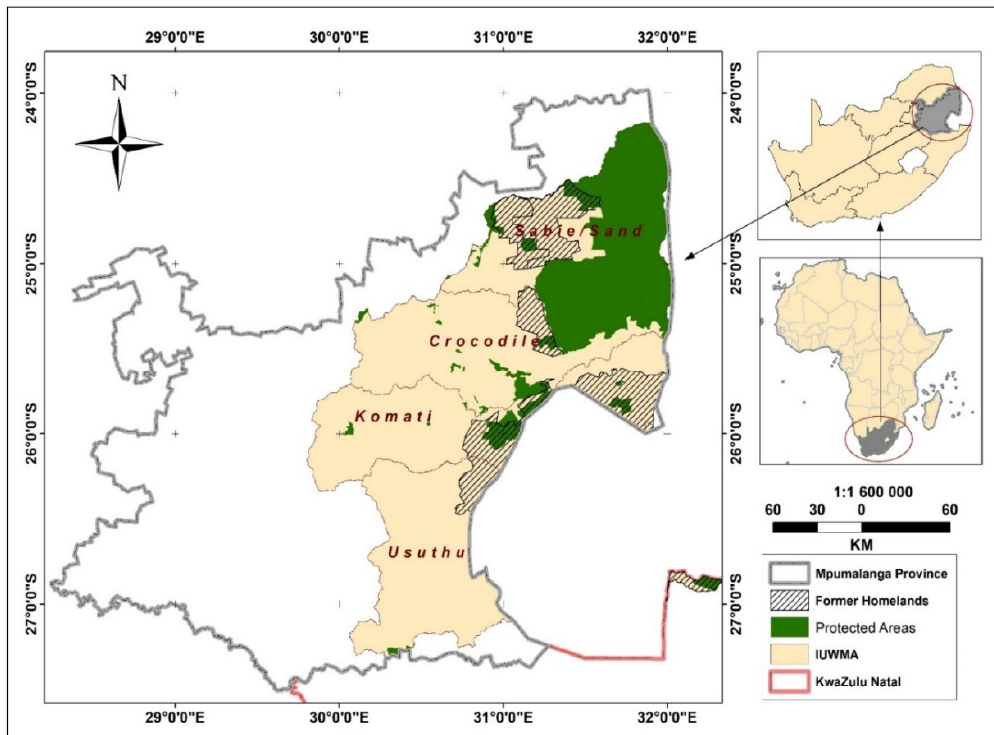
Figure 1. The IUWMA and the sub-catchments also showing former homelands, areas established under apartheid, and reflect the current rural informal smallholder agricultural sector.